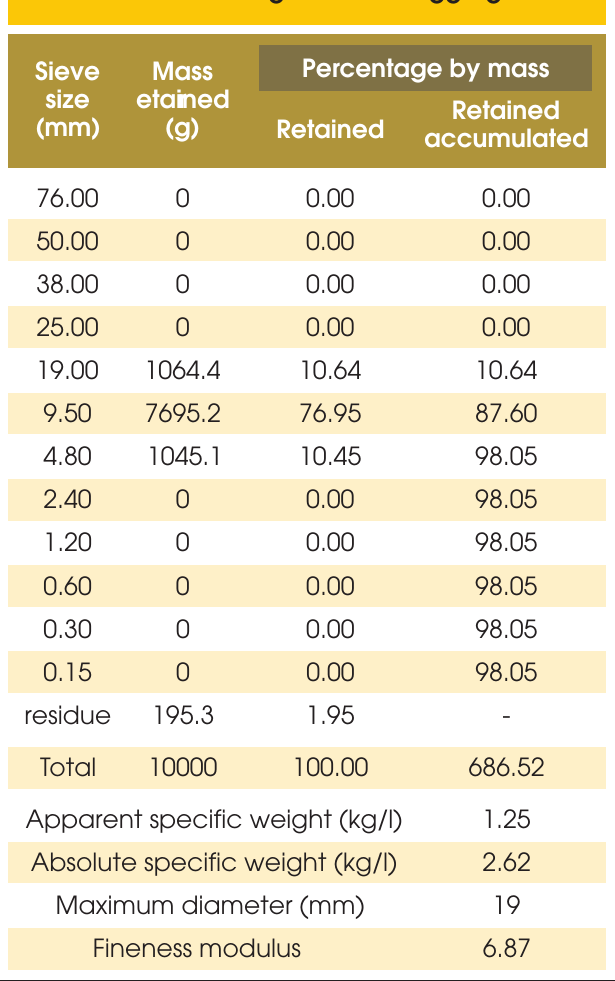
Table 2 – Grading of coarse aggregate